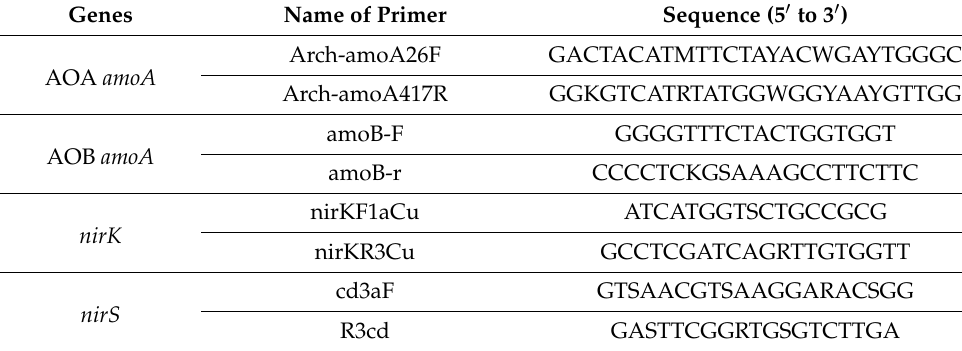
Table 2. Primer information used in the experimental procedure. Genes Name of Primer Sequence (5 (cid:48) to 3 (cid:48)